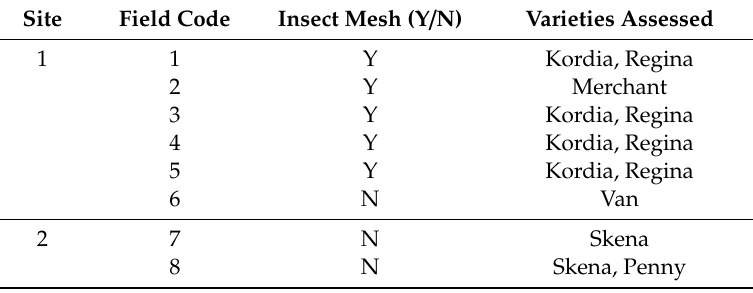
Table 4. Cherry varieties in cladding protected commercial orchards used in the farm fortnightly spray program trial in